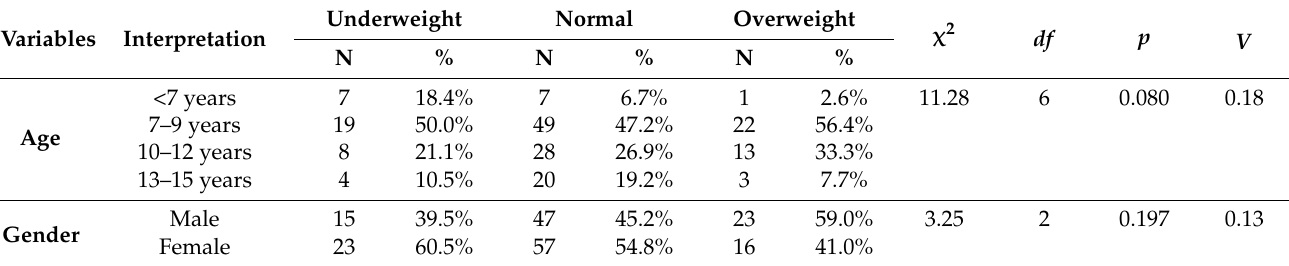
Table 2. BMI values taking into account age and